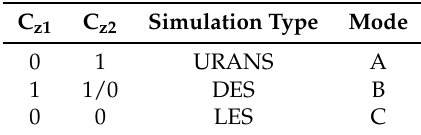
Table 1. Different modes of the ZDES formulation determined by the C z 1 and C z 2